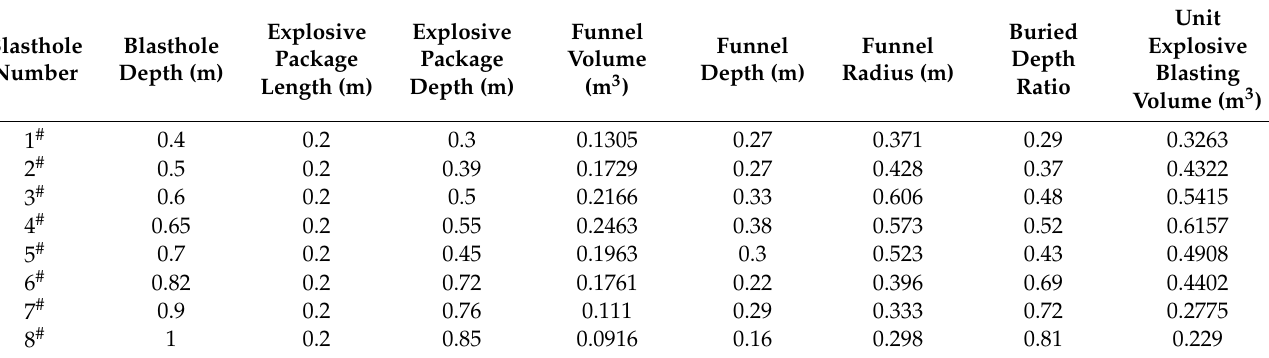
Table 3. Funnel test results of single-hole blasting.